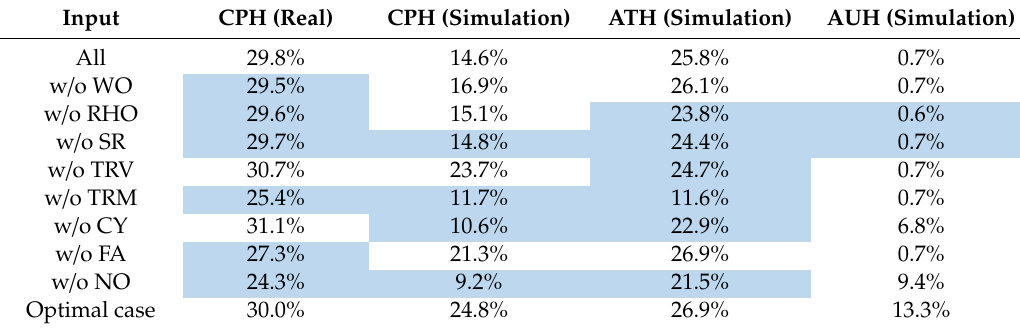
Table 7. Overall predictive performance of the method depending on the input parameters considered. “All” refers to all eight attributes; The prefix “w / o” means that this particular attribute was not included